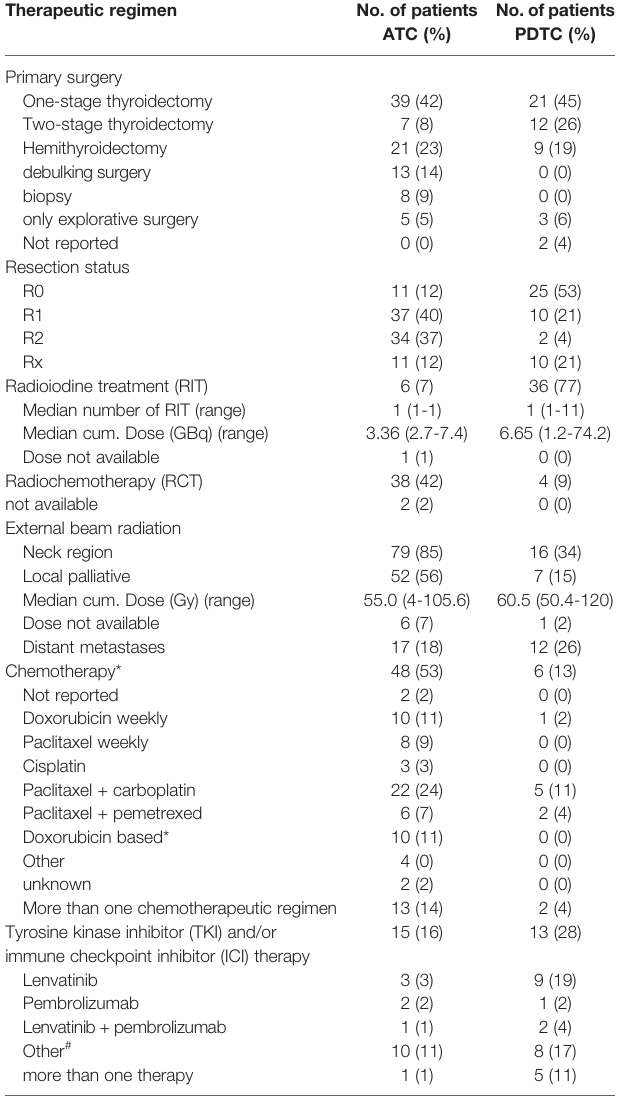
TABLE 3 | Therapeutic regimens in patients with ATC or PDTC. Therapeutic